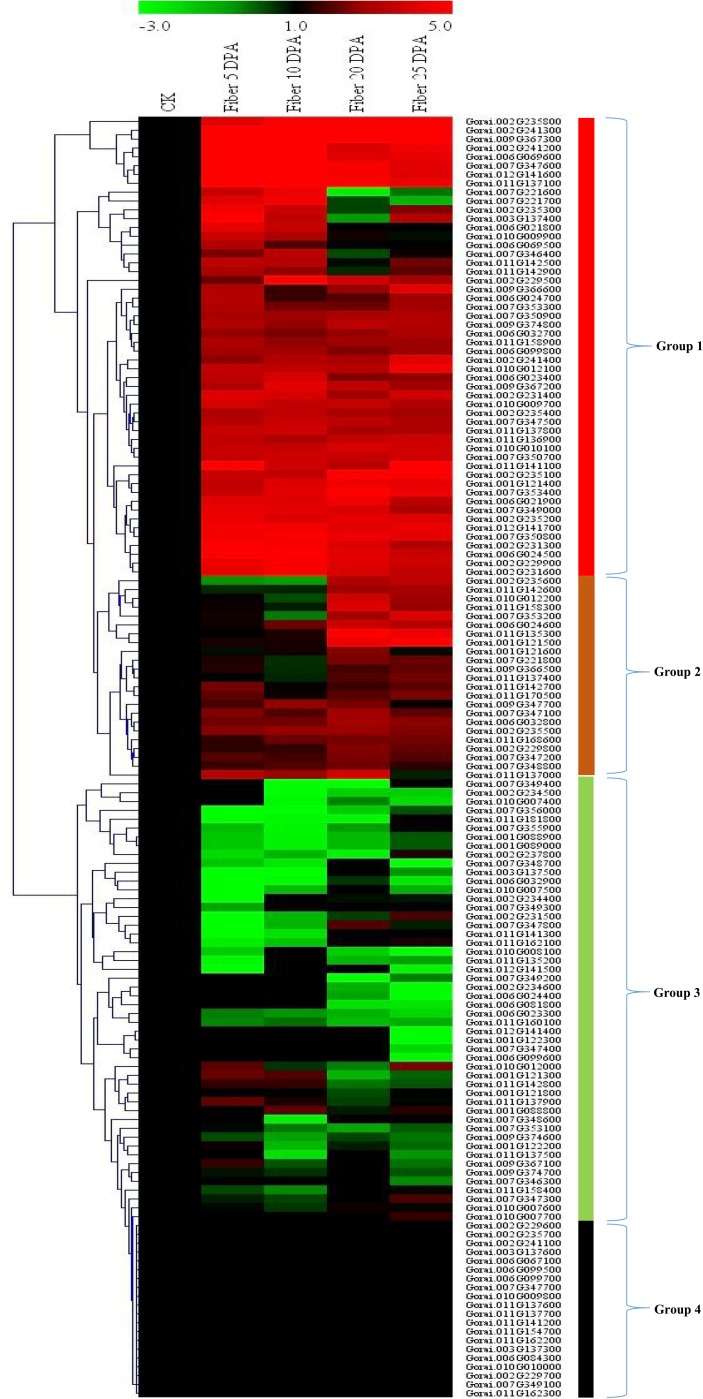
Heat map for the RNA expression seq. for the mined genes at the SDR regions in relation to fiber development.The heat map was visualized using Mev.exe program (Showed by log 2 values). (i) Red-up regulated, green-down regulated and black- no expression. DPA: day post anthesis.